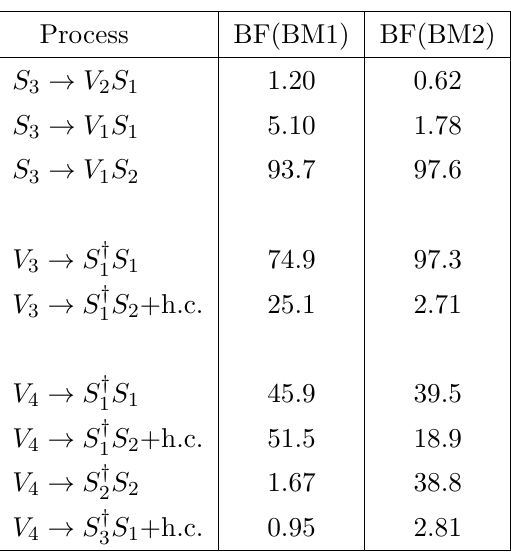
Table 2 . Branching fractions for the various decay modes in per cent for the next highest gauge and scalar KK states in both BM scenarios discussed in the